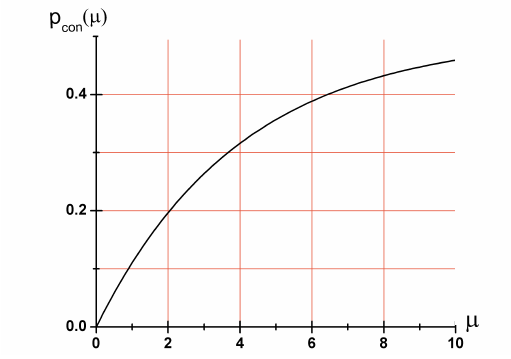
Figure 2. The probability that an honest Bob gets conclusive bit changing with µ